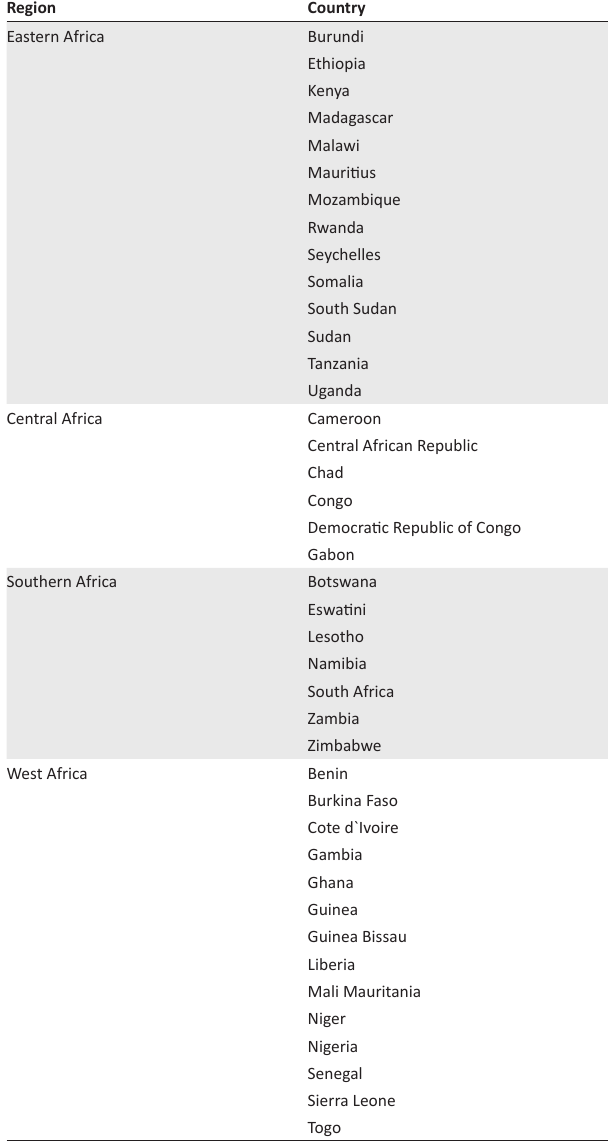
TABLE 1: Sub-Saharan African countries by region.